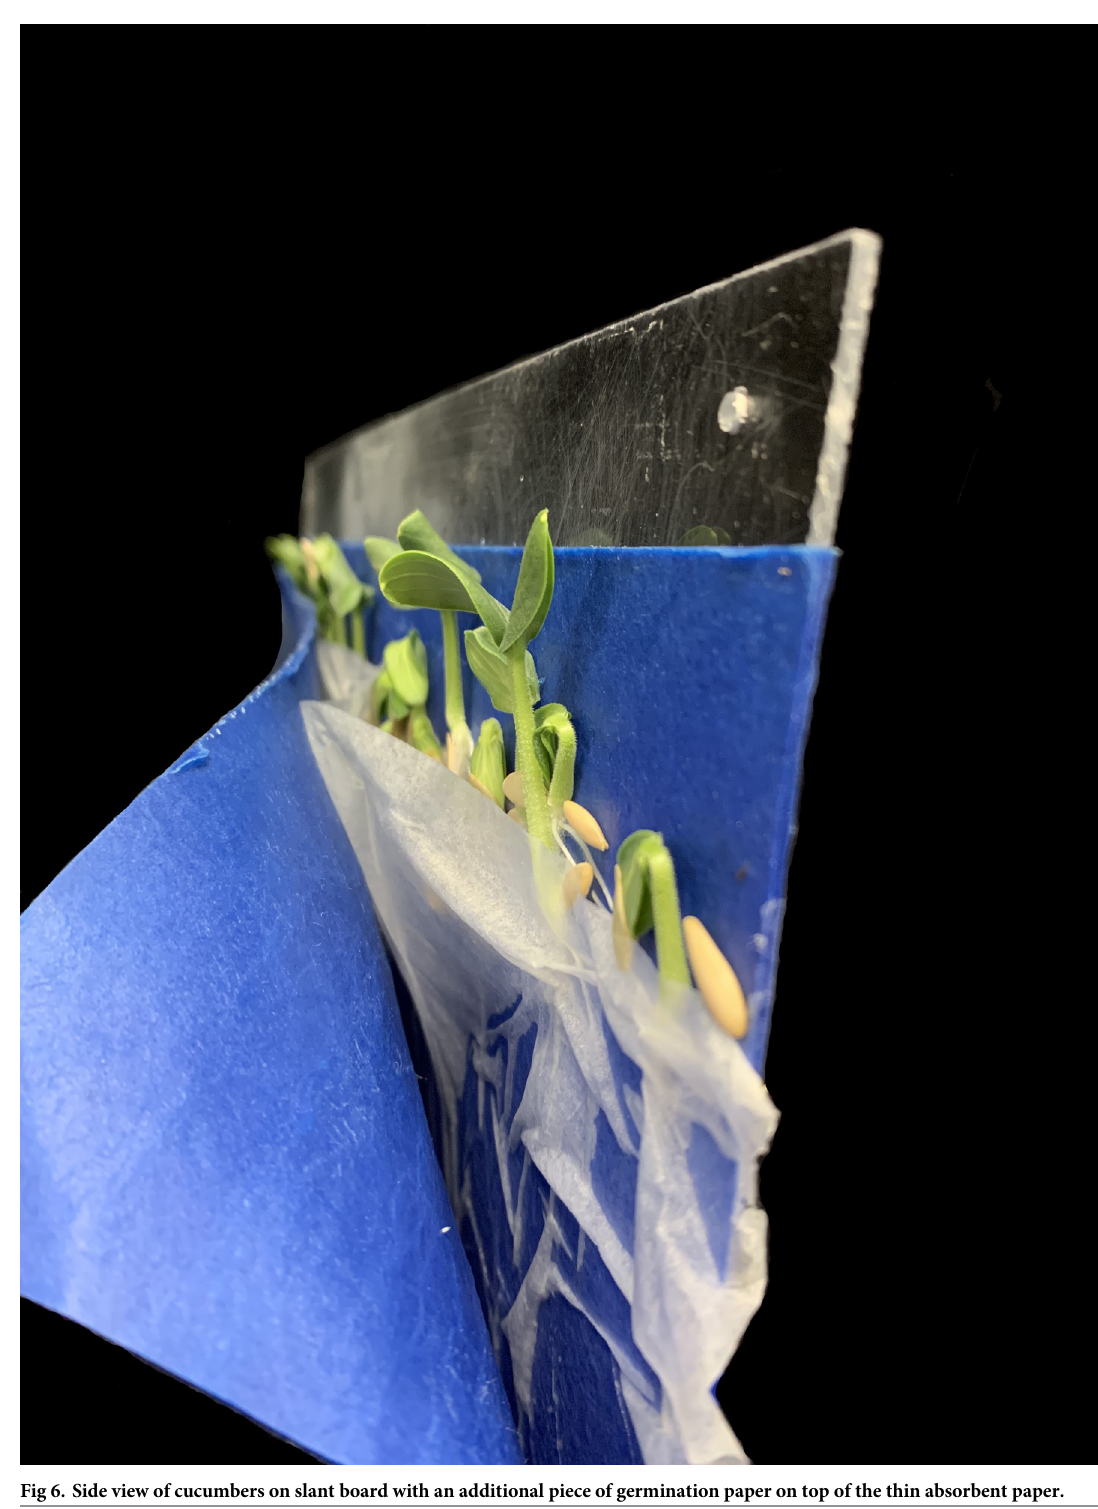
Fig 6. Side view of cucumbers on slant board with an additional piece of germination paper on top of the thin absorbent paper.